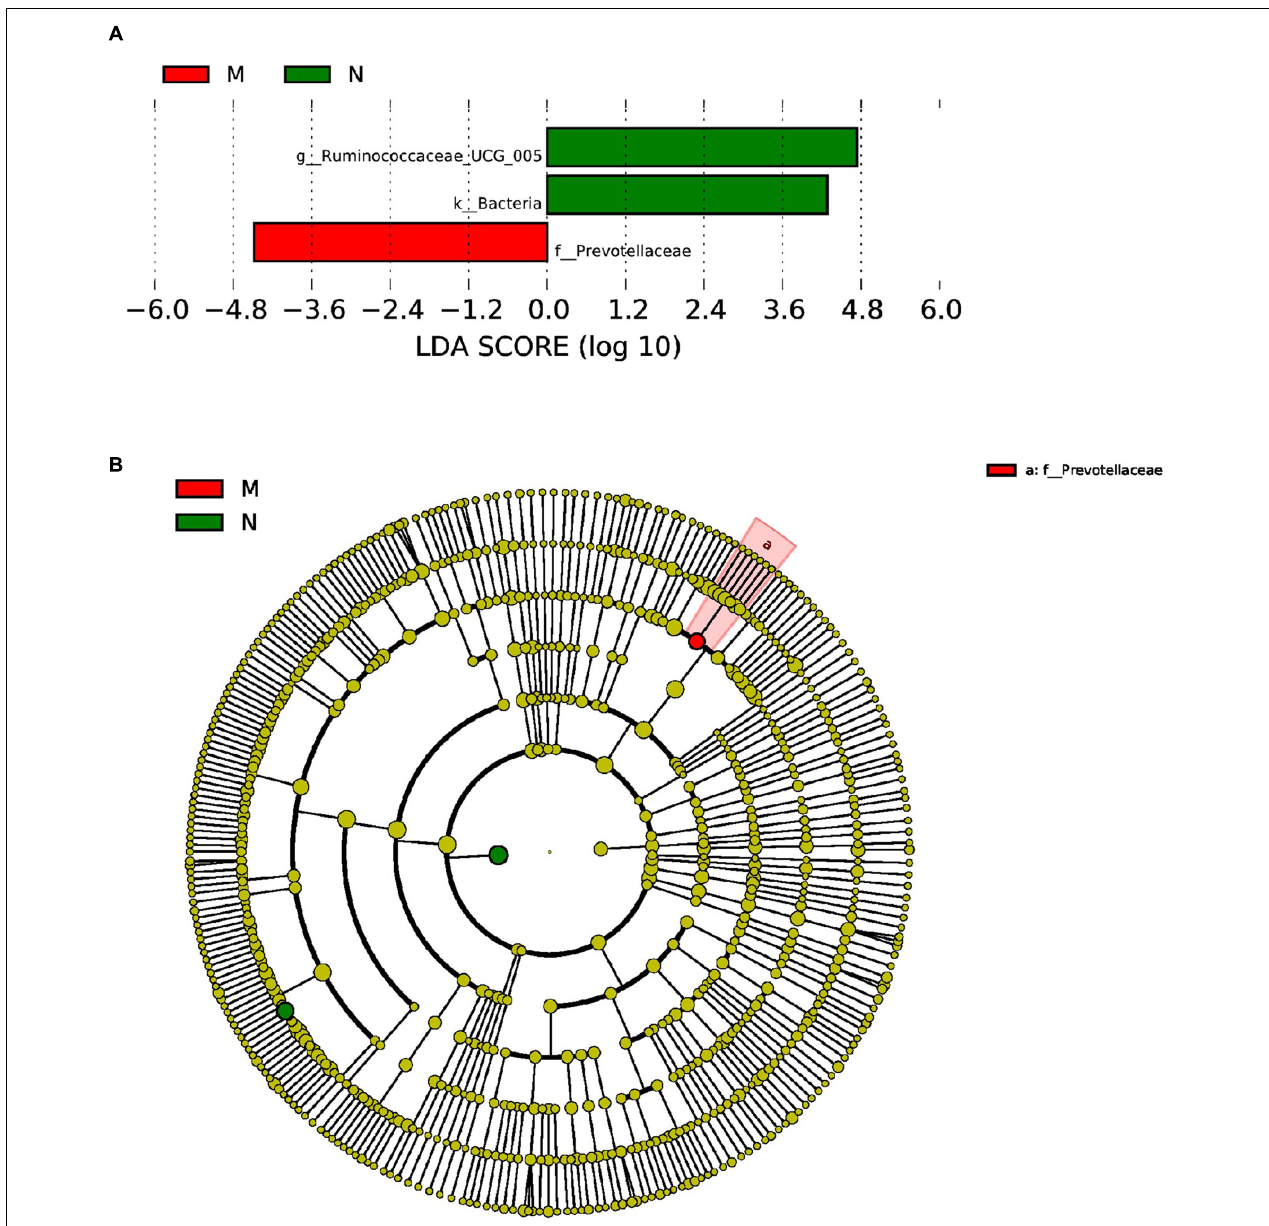
FIGURE 9 | LEfSe (LDA Effect Size) analysis (A) and the cladogram (B) in blue sheep. The different colors represent different groups. The histogram (A) shows the biomarkers with statistical difference between groups and the lengths of the bars indicate the influential degree of species. The cladogram (B) demonstrates the classification of taxa at five levels, and the red and green circles indicate the differences in relative abundance. Non-significant differences are expressed by the yellow circles. M, low-altitude blue sheep; N, high-altitude blue